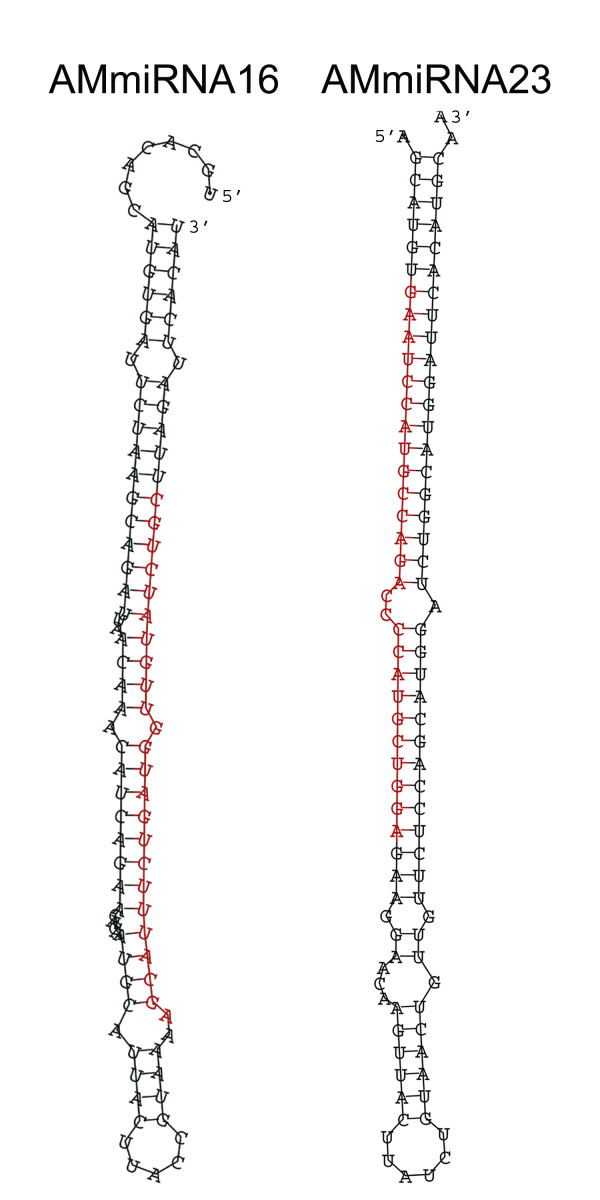
Structure of two A. mexicanum miRNAs (AMmiRNA16, AMmiRNA23) that were predicted from axolotl introns. The red bases indicated positions where the predicted miRNA sequences show complete identify to small RNAs isolated from regenerating limbs.